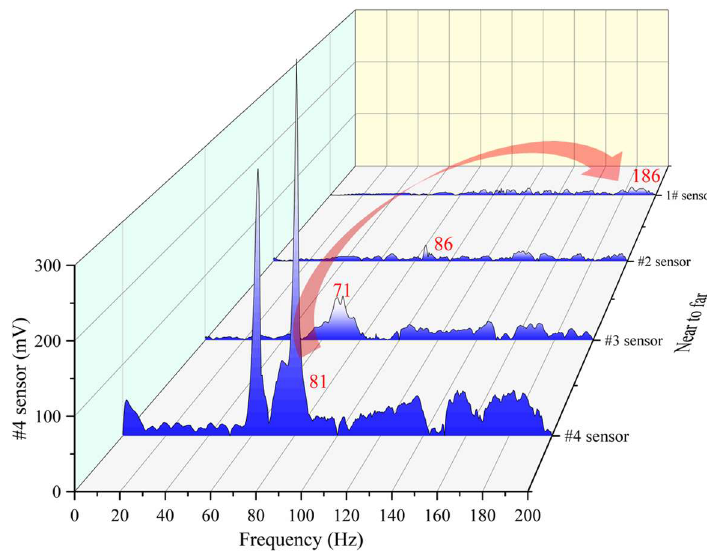
Figure 11. Main frequency increasing case event.